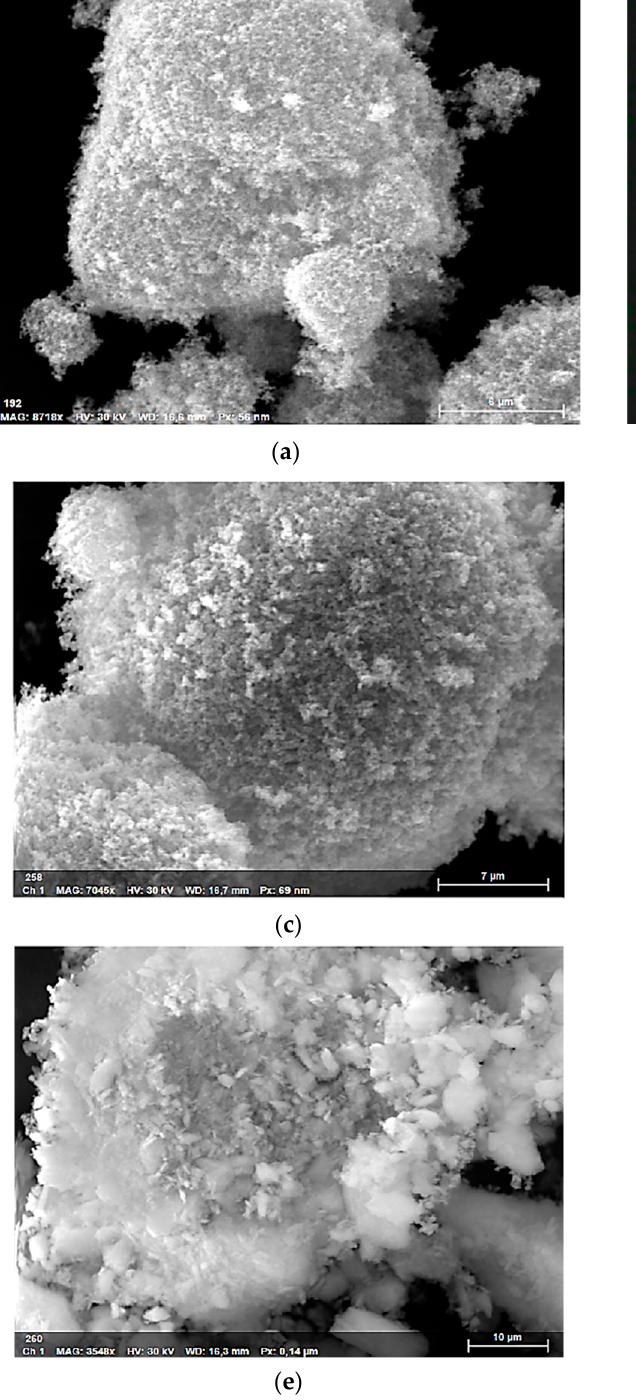
Figure 3. SEM and EDX mapping of nanoparticle clusters: ( a , b ) ZnO, ( c , d ) TiO 2 , and ( e , f ) zeolite. XRD patterns of the synthesized nanoparticles are depicted in Figure 4. These graphs were obtained by employing the PXRD technique (powder X-ray diffraction), which is a rapid technique that measures the diffraction pattern of crystalline material.